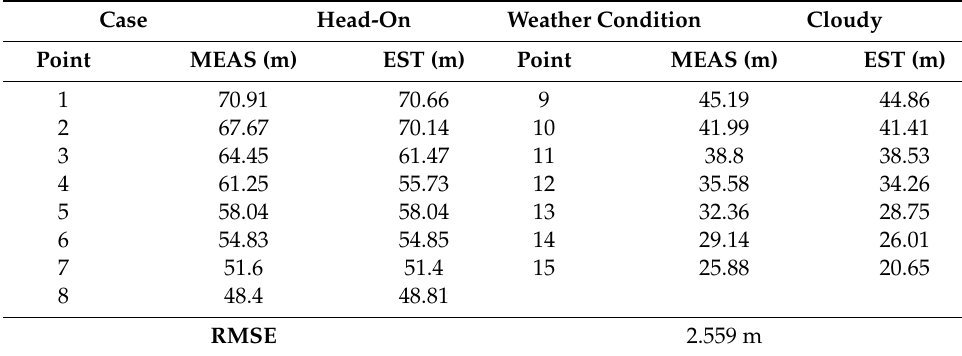
Table 8. Experiment 3 (estimation vs. GPS measurement).